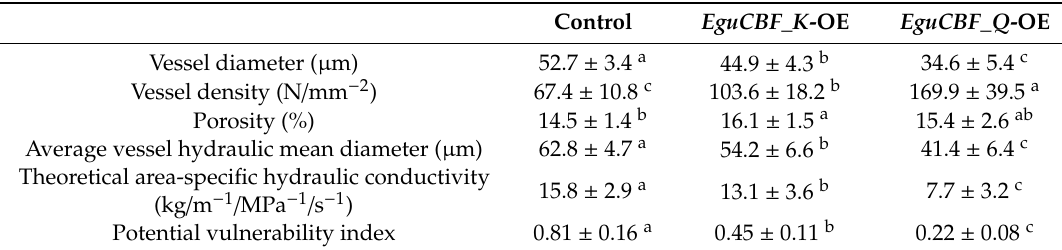
Table 1. Vessel properties in Eucalyptus CBF -overexpressors.